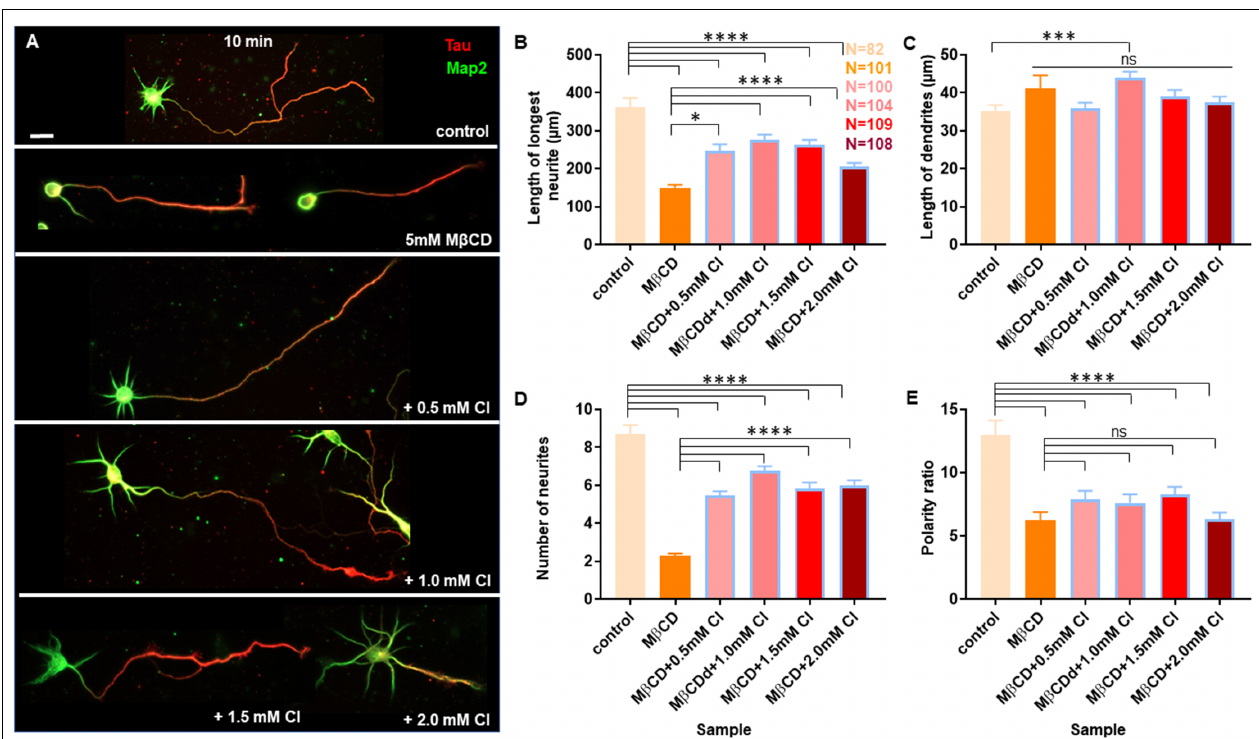
FIGURE 6 | Transient cholesterol replenishment rescues neuronal developmental defects from cholesterol sequestering. Neurons at DIV1 were transiently treated with 5 mM M β CD (referred to as M β CD in the figure) for 10 min to sequester cholesterol. The treated neurons were immediately supplemented with varying concentrations of exogenous cholesterol (Cl) for 10 min. The cells were grown to DIV3 and labeled with Tau (red) and Map2 (green). (A) A gallery of control and cells treated with 5 mM M β CD followed by varying concentrations of cholesterol is presented. (B–E) Represents the length of the longest neurite (B) , length of dendrites (C) , number of neurites in each cell (D) , and the neuronal polarity ratio (E) of the treated cells. The developmental defects observed for cholesterol sequestered neurons were significantly rescued upon supplementing exogenous cholesterol. N denotes the number of cells from three independent cultures. One-way Anova was performed to test the significance of the difference between the means. Significance was tested for each sample against the control as well as against M β CD alone. ∗∗∗∗ p < 0.0001, ∗∗∗ p < 0.001, ∗ p < 0.05, and ns non-significant. Scale bar indicates 20 µ